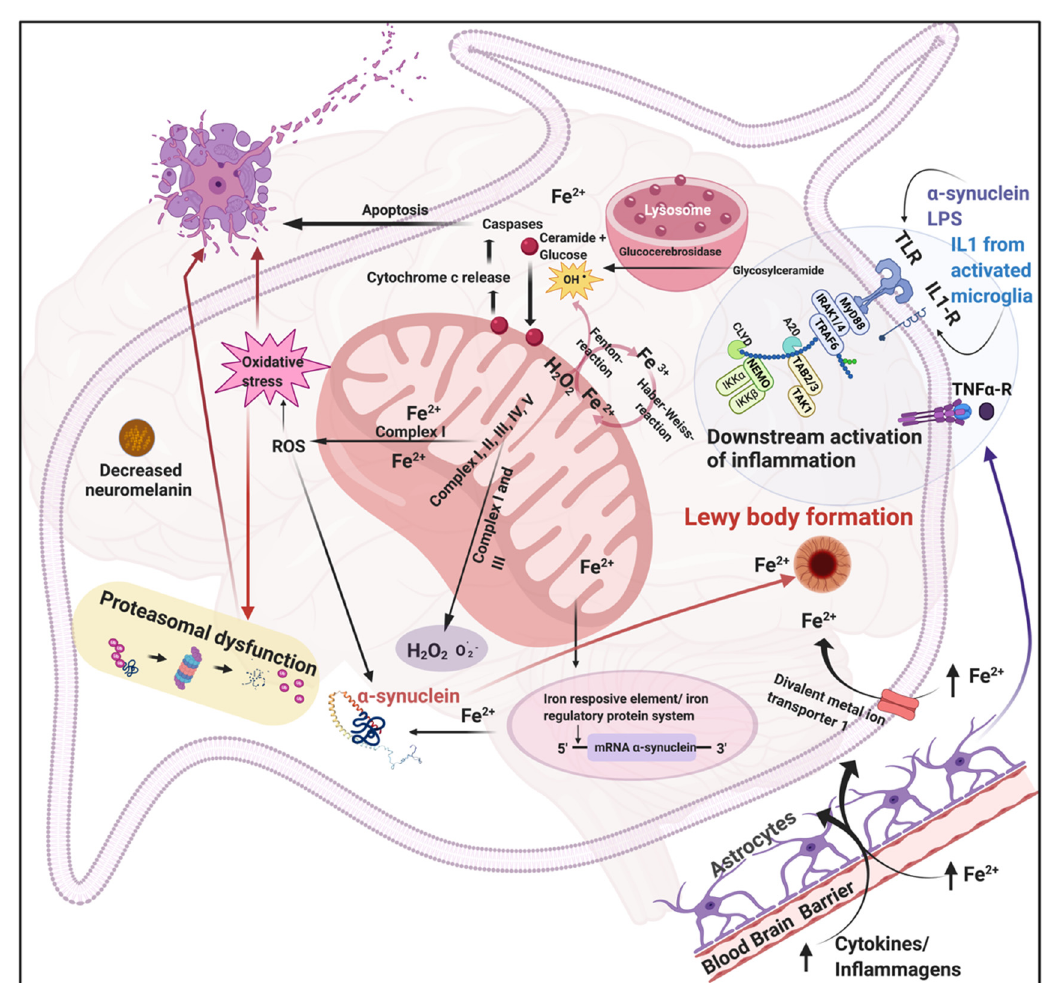
Figure 2. Interactions in a PD neuron between mitochondria, lysosomes, iron, and α -Syn production and ultimately proteasomal dysfunction, oxidative stress and apoptosis (adapted from [20]). The figure illustrates the interplay between mitochondria and lysosomes during the apoptotic cell death that characterizes the death of neurons in the substantia nigra that is the hallmark of PD. The location of receptors like the TLR and IL-1 receptors and the metal ion transporter 1 are shown. These receptors and transporter are known to bind bacterial inflammagens, IL-1, and Fe 2+ . In PD, there is also a loss of neuromelanin in the substantia nigra, and this could lead to enhanced calcium messaging. These molecules play a fundamental role in the downstream activation of inflammation and oxidative stress, and ultimately play a crucial role in α -Syn and Lewy body formation.